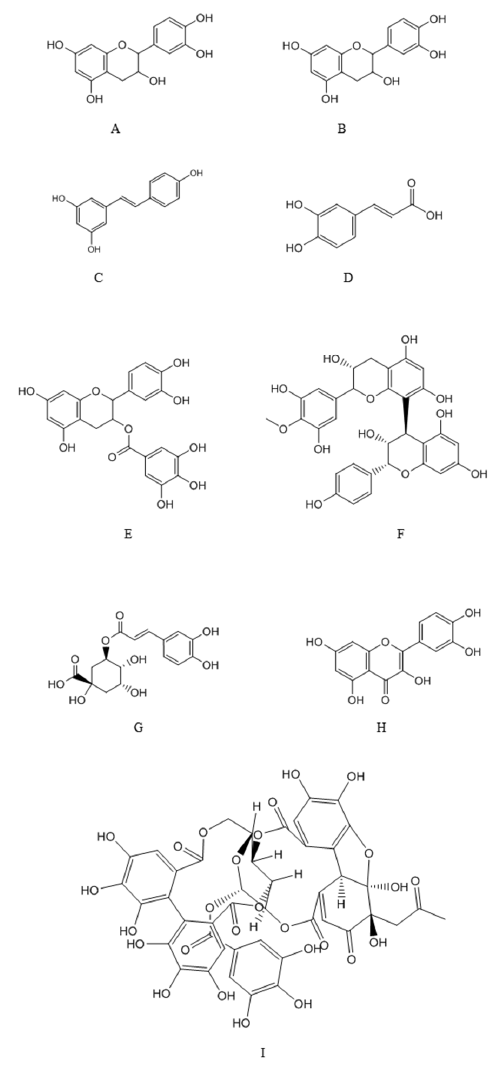
Figure 3. Structure of main polyphenols classes. A: catechins; B: Epicathechins; C: Resveratrol; D: Caffeic acid; E: Proanthocyanidin; F: Epicatechin gallate; G: chlorogenic acid; H: Quercetin; I: Ellagitannin.